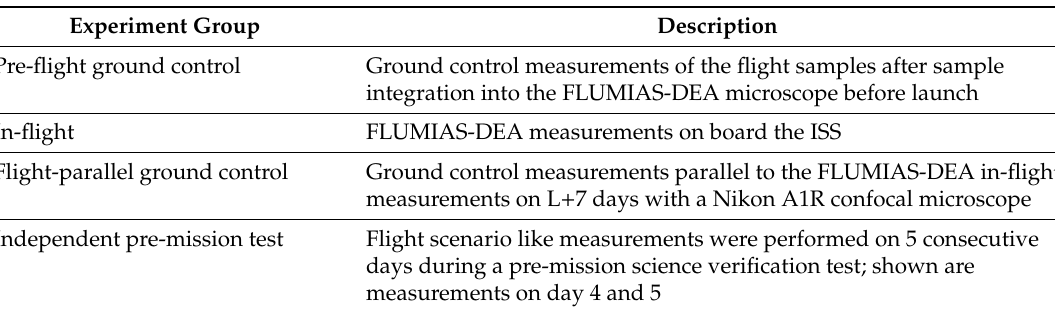
Figure 5. Experiment sequence of the FLUMIAS-DEA investigation aboard the ISS. Table 4. Experiment groups .